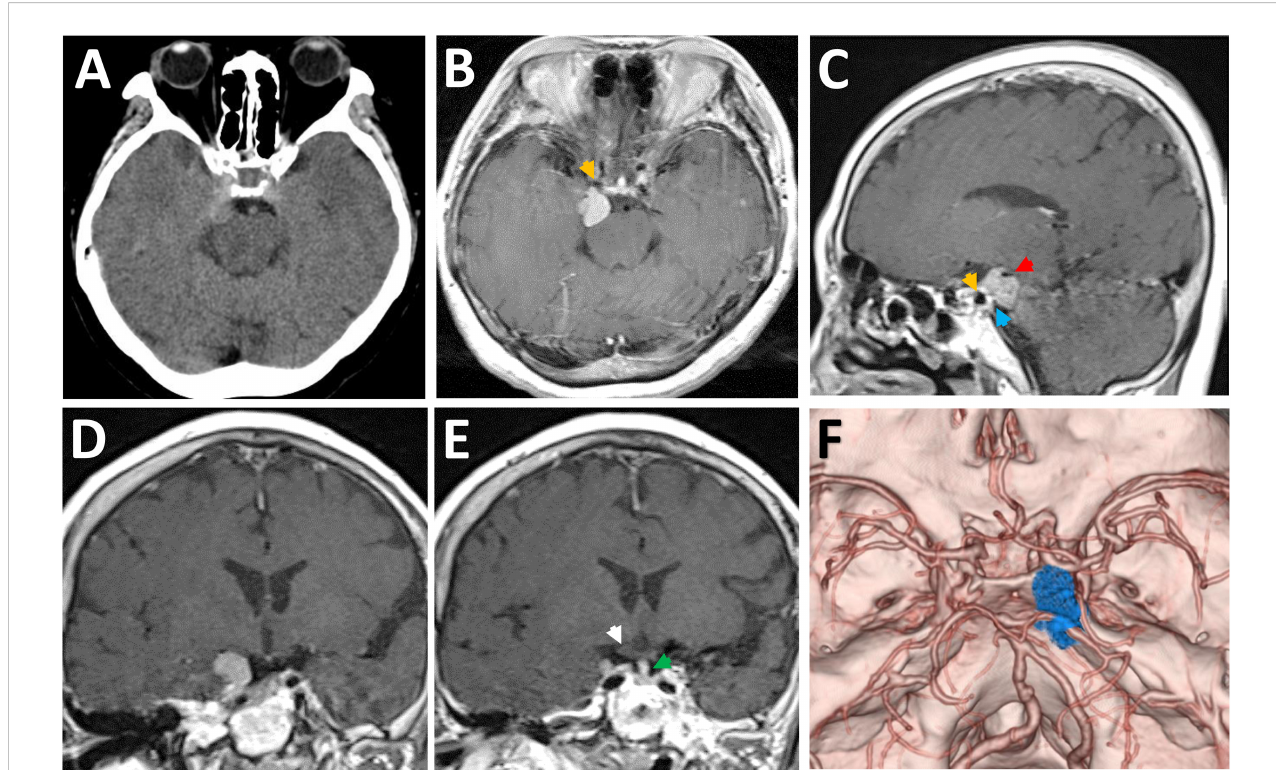
FIGURE 1 Radiological evaluation of the retrosellar lesion preoperatively. (A) Preoperative CT image showing a hyperdense lesion on the right-sided of posterior clinoid process. (B-E) Post-contrast (gadolinium-enhanced) axial (B) , sagittal (C) , and coronal (D, E) MRI images showing the thick enhancement of the lesion as well as the relative position to surrounding neural structures. (F) Preoperative CT angiography images demonstrating the relative location of tumor to the Willis ’ circle and the dorsum sellae. The yellow arrows denote the posterior bend of caveronous carotid artery. The red arrow indicates the posterior cerebral artery. The white arrow denotes the up-elevated right optic chiasma. The green arrow indicates the pituitary stalk. The blue arrow indicates the dural detachment of the tumor on the posterior clinoid